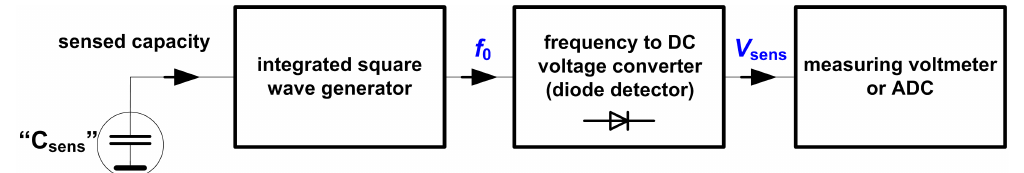
Figure 1. Principle of the capacity